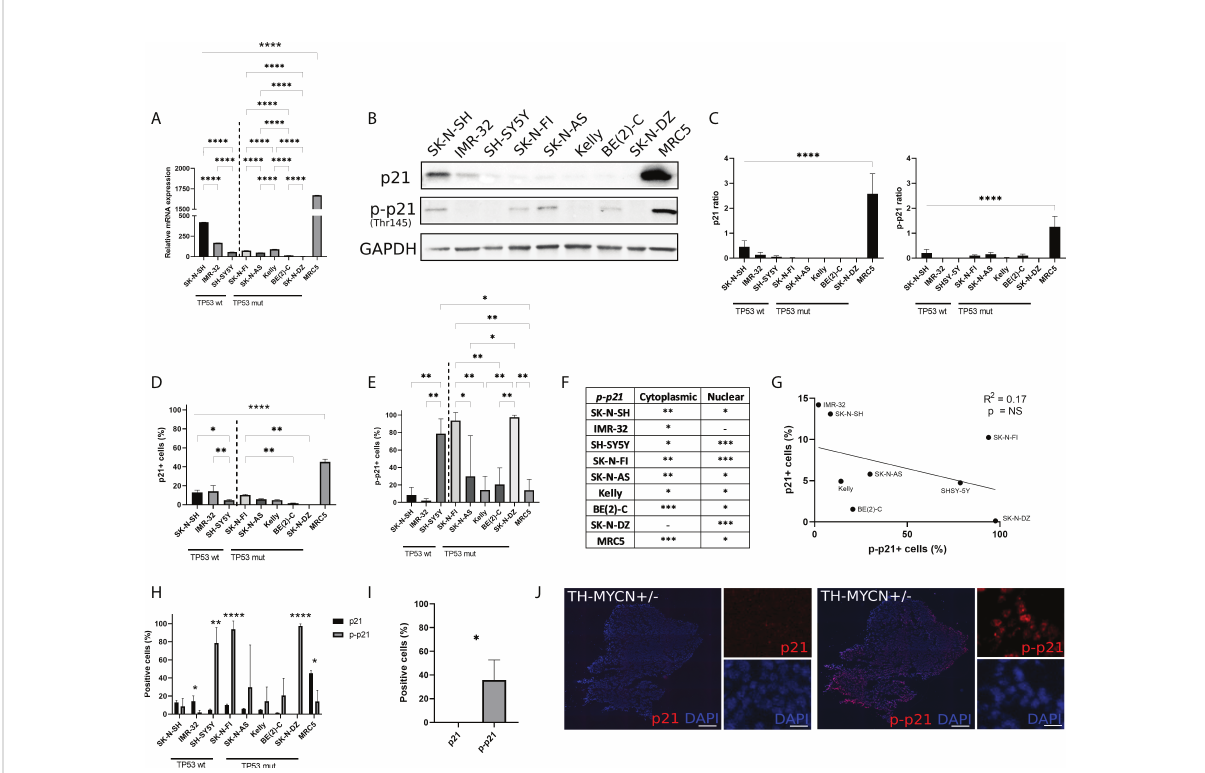
FIGURE 1 Endogenous p21 and p-p21 expression. (A) Relative expression of p21 mRNA (CDKN1A), normalized to HL-60. The MRC5 cell line showed the highest endogenous expression compared to the remaining cell lines. Among the NB cell lines the TP53 wt cell line SK-N-SH showed the highest endogenous expression compared to the remaining cell lines. * = p<0.05, ** = p<0.01, *** = p<0.001, **** = p<0.0001, not signi fi cant p>0.05. One-way ANOVA with Tukey post hoc test. Mean ± SEM, n=4. (B) Western blot analysis showing protein expression of p21 (21 kDa), p- p21 (Thr145) (32 kDa), and loading control GAPDH (37 kDa) in NB cell lines and MRC5. (C) Western blot analysis showed the highest endogenous expression of p21 or p-p21 in MRC5 compared to the remaining cell lines. **** = p<0.0001, not signi fi cant p>0.05. One-way ANOVA with Tukey post hoc test. Mean ± SD, n=3-4. (D) Fraction of p21 expressing cells in each cell line. The highest fraction of p21 positive cells was observed in the MRC5 cell lines. Among the NB cell lines, the TP53 wt cell lines showed generally a higher fraction of cells positive for p21 compared to the TP53 mut cell lines. * = p<0.05, ** = p<0.01, **** = p<0.0001, not signi fi cant p>0.05. One-way ANOVA with Tukey post hoc test. Mean ± SD, n=3. (E) Fraction of p-p21 (Thr145) expressing cells in each cell line. Three cell lines, SH-SY5Y, SK-N-FI, and SK-N-DZ showed the highest fraction of p-p21 positive cells. * = p<0.05, ** = p<0.01, not signi fi cant p>0.05. One-way ANOVA with Tukey post hoc test. Mean ± SD, n=3. (F) Investigation of spatial localization of the p-p21 protein. The BE(2)-C and MRC5 cell lines showed highest cytoplasmic p- p21 expression, whereas SH-SY5Y, SK-N-FI, and SK-N-DZ showed the highest nuclear p-p21 expression. - = no expression, * = low expression, ** = moderate expression, *** = high expression. n=3. (G) Fraction p21 versus p-p21 positive cells and the correlation between the two. A trend in the correlation was observed, however it was not signi fi cant. Linear regression with Pearson ’ s correlation coef fi cient, NS= not signi fi cant p>0.05. n=3. (H) Comparison between the fraction of p21 and p-p21 expressing cells in each cell line. IMR-32 and MRC5 had a lower fraction of p-p21 positive cells compared to p21 positive cells, whereas SH-SY5Y, SK-N-FI, and SK-N-DZ had a higher fraction of p-p21 positive cells compared to p21 positive cells. * = p<0.05, ** = p<0.01, **** = p<0.0001, not signi fi cant p>0.05. Student´s t-test. Mean ± SD, n=3. (I) The TH- MYCN heterozygote mouse model did not show p21 positive cells, whereas 35.9% ± 16.8 of tumour cells where positive for p-p21. * = p<0.05. Student´s t-test. n=3. (J) representative pictures of p21 and p-p21 staining on tumour tissue in the TH-MYCN heterozygote mouse model. Scale bar 200 µm and 20 µm,